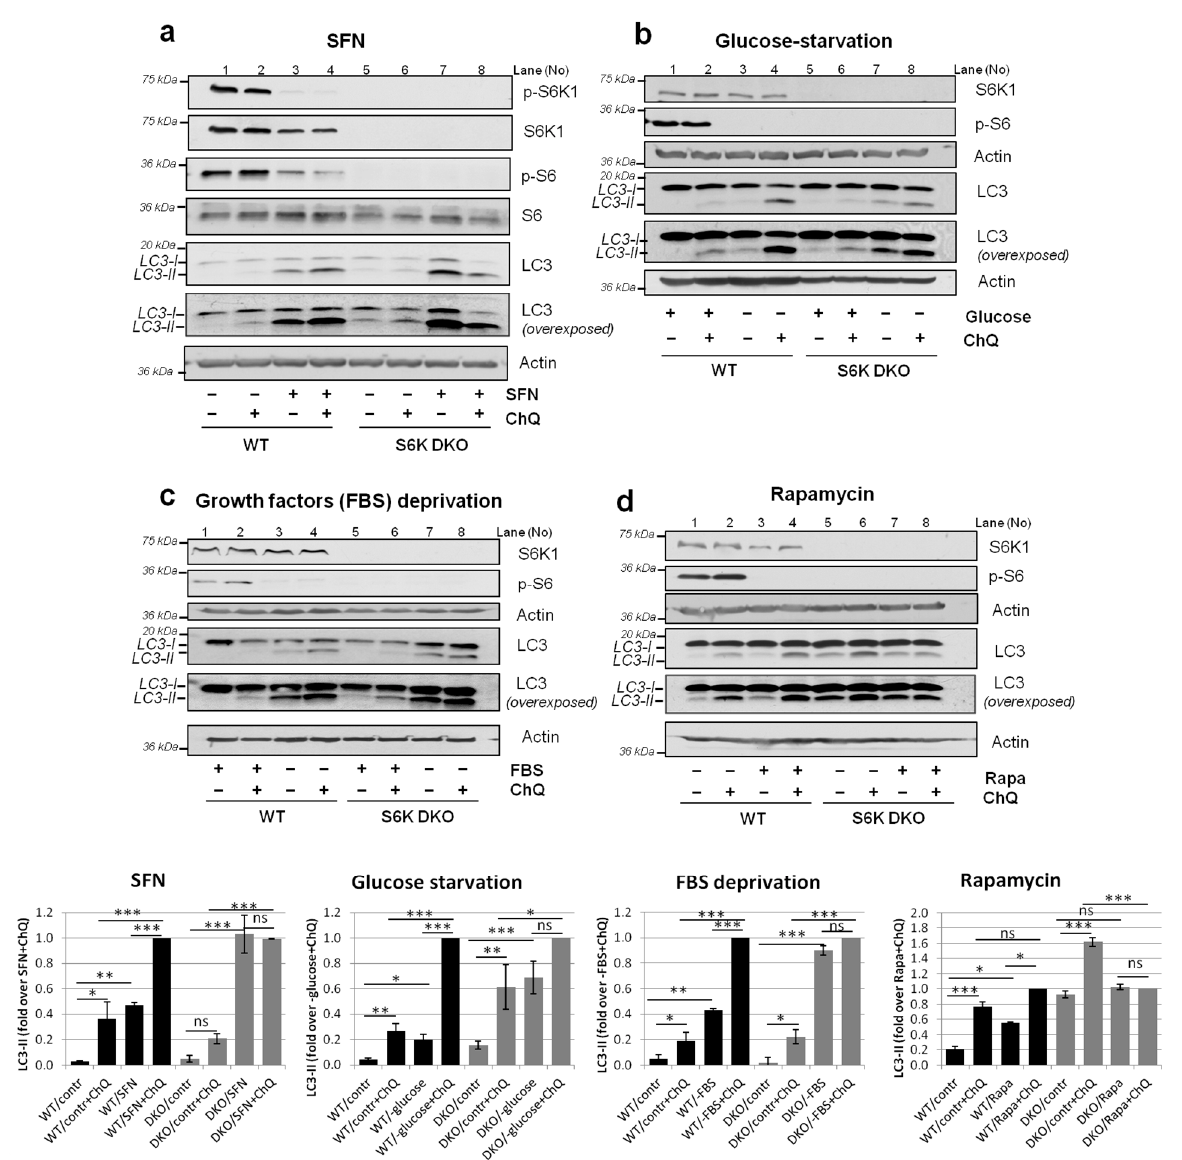
Figure 1. Impaired autophagic flux under stress conditions is a general phenotype of S6K DKO MEF. WT and S6K DKO MEF were grown under basal conditions: in a medium with a vehicle (DMSO; a , d ) or a complete medium ( b , c ). Alterna- tively the cells were exposed to stress, by culturing in a medium deprived of either glucose (for 3 h; b ) or growth factors (for 16–24 h; c ); by a 16-h treatment with 20 µM sulforaphane (SFN; a ); or a 3-h treatment with 100 nM rapamycin (Rapa; d ). To assess the autophagic flux, a lysosomal inhibitor, chloroquine (ChQ; 10 µM), was added for the last 2 h of treatment, autophagic flux, a lysosomal inhibitor, chloroquine (ChQ; 10 µ M), was added for the last 2 h of treatment, as as indicated. The LC3, p-S6K1 (Thr389), S6K1, p-S6, and S6 protein levels were evaluated by western blotting. After the